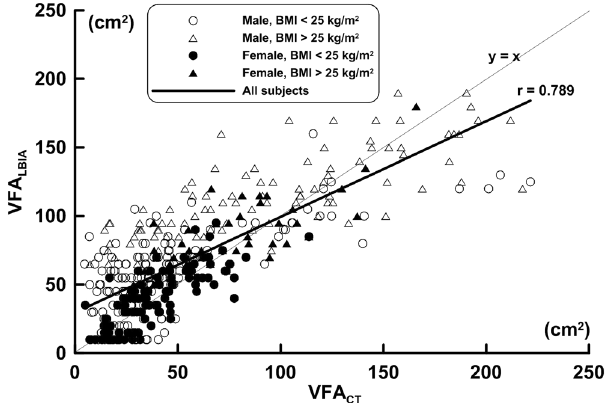
Figure 1. Regression analysis and scatterplot between VFA CT and VFA LBIA for males and females. VFA LBIA = 0.698 VFA CT + 29.521, n = 381, p < 0.001, r = 0.789, Standard estimate of error (SEE) = 24.470 cm 2 . The lines of identity and regression are shown in the figure.